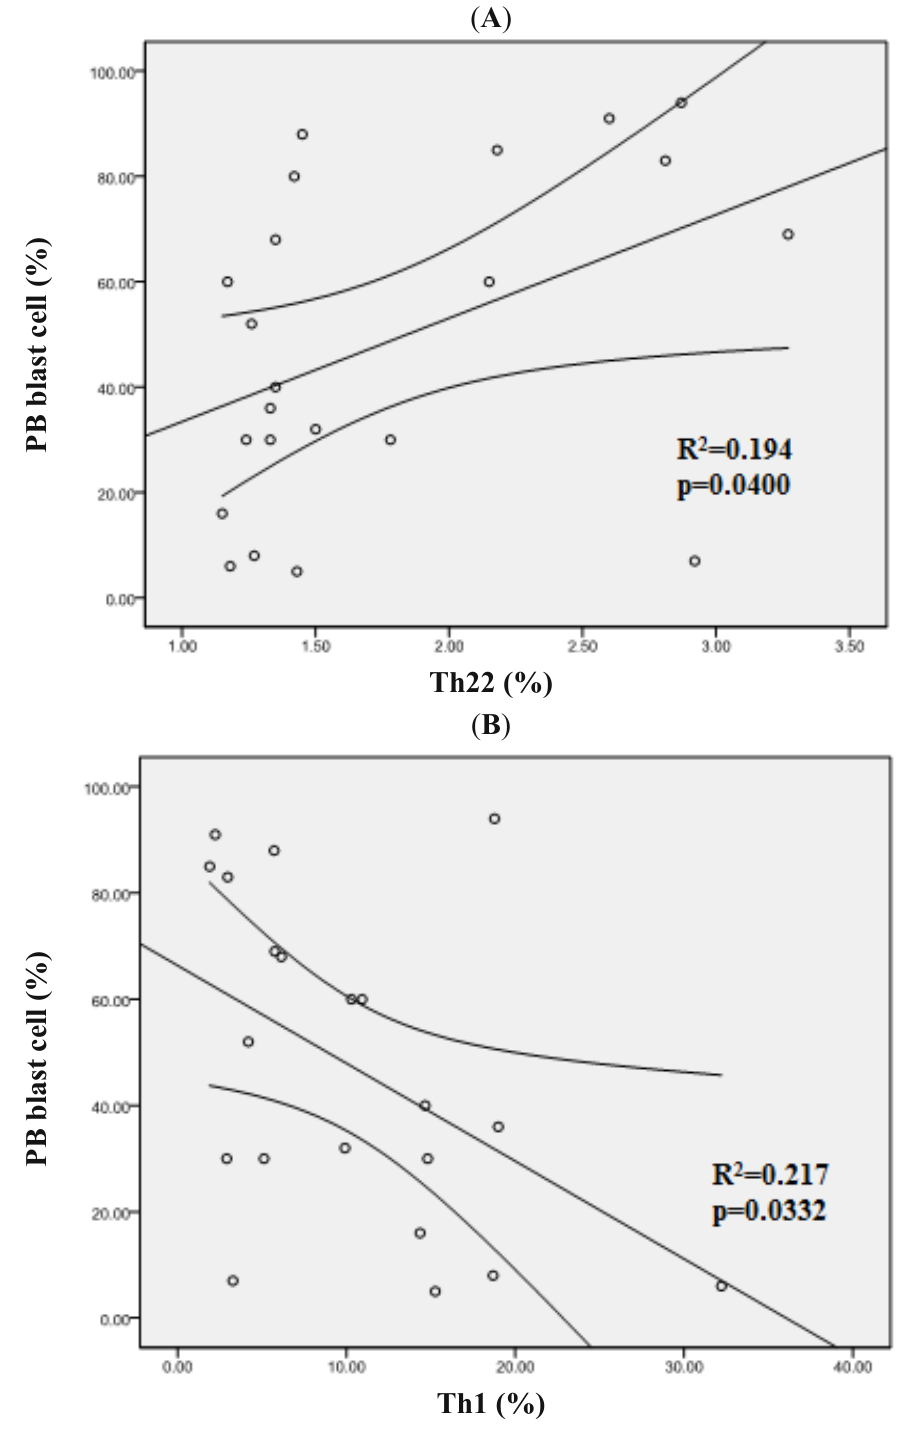
Figure 7. Clinical relevance of Th22 and Th1 cells in AML patients. ( A ) A positive correlation was observed between Th22 cells and PB blast cell in ND AML patients; ( B ) A negative correlation was observed between Th1 cells and PB blast cell in ND AML